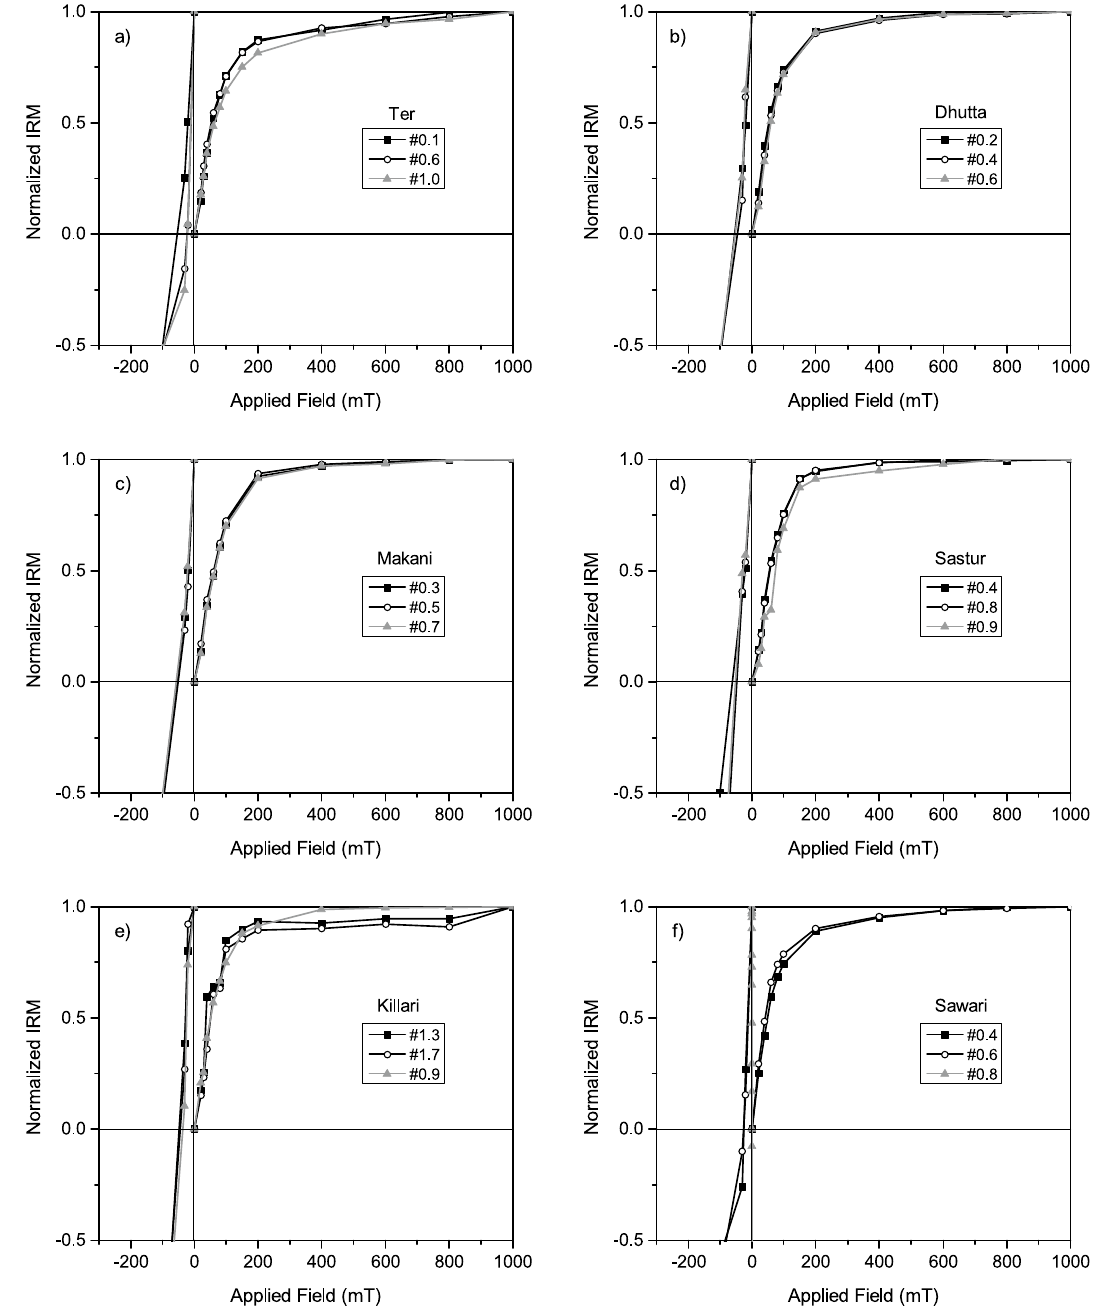
Figure 4. ( a – f ) Acquisition of isothermal remanent magnetization and backfield demagnetization for representative samples from the selected In the Makani section, in the middle reaches of the Tirna River, K min axes are also vertical to incline that are oriented mostly towards E–W, although a few K min axes show inclination towards NNE (Fig. 6). The correspond- ing K max axes are horizontal to sub-horizontal and the majority of data are oriented in E–W. Like the Dhutta section, the long axis of K min ellipse is also statistically parallel or sub-parallel to the orientation of K max axes. In P ′ versus T plot, data are plotted in oblate field in majority of cases (73%) with significant distribution in prolate quadrant (27%) as well. All the data have P ′ < 1.015 (Fig. 7b). In the Sastur succession, the majority of K min axes are vertical to incline in E-W direction (Fig. 6), whereas the K max axes are horizontal to sub-horizontal and are oriented in ENE–WSW direction in average. Like the Dhutta and Makani sections, the long axis of K min ellipse is also statistically parallel or sub-parallel to the orientation of K max axes. The P ′ versus T plot reveals that the majority of data from Sastur succession lie in the oblate field (85%) with a few in prolate field (15%), wherein and the P ′ values for the majority of data are ≤ 1.015 (Fig. 7b). However, a few data in the oblate field has P ′ values between ~ 1.015 and 1.04.